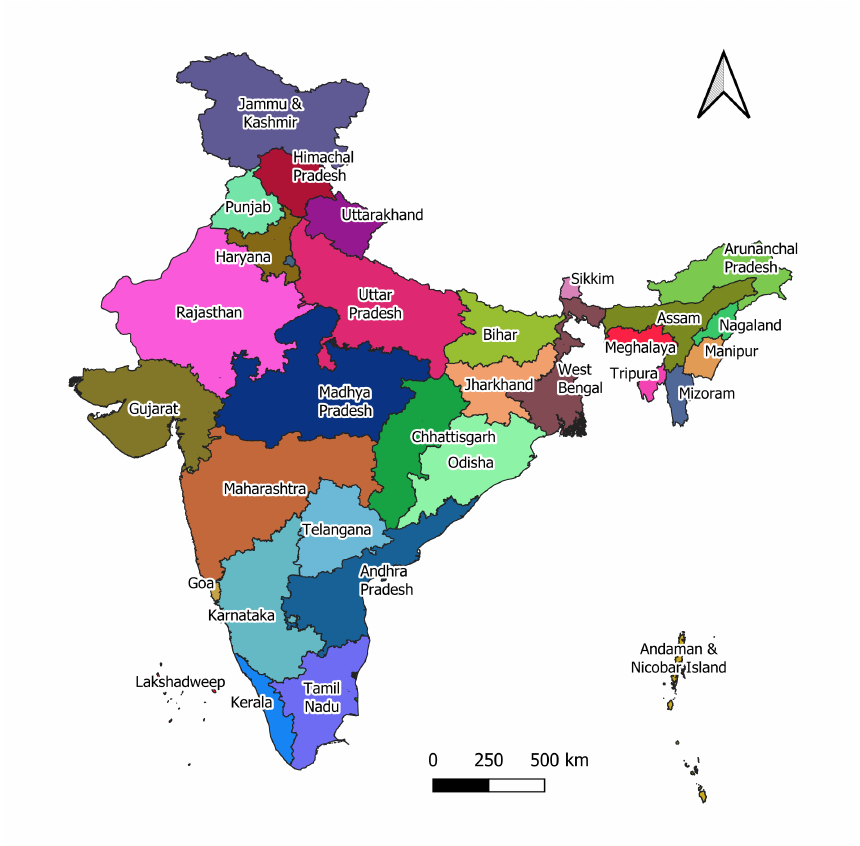
Figure 1. Study area map of India, labeling only